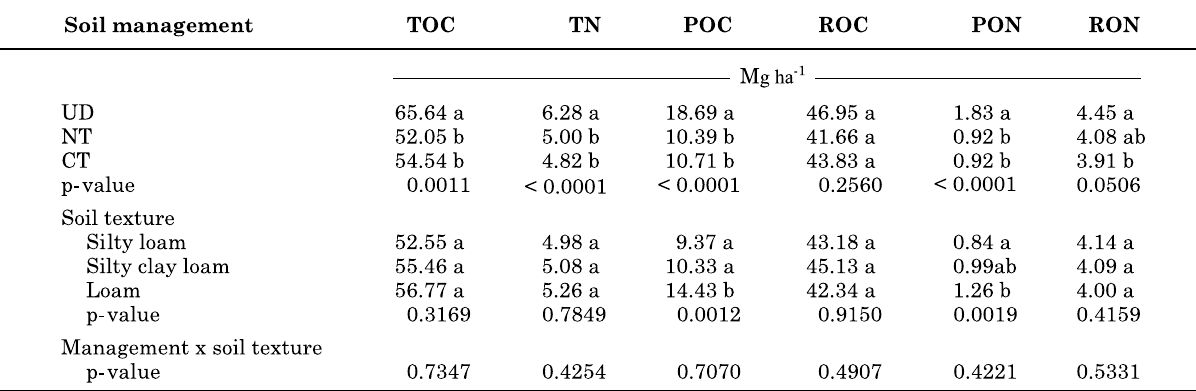
Table 2. Quantities (stocks) of total organic carbon (TOC), total nitrogen (TN), particulate organic carbon (POC), resistant organic carbon (ROC), particulate organic nitrogen (PON) and resistant organic nitrogen (RON) per unit of area corrected by equivalent mass for the different managements and soil texture